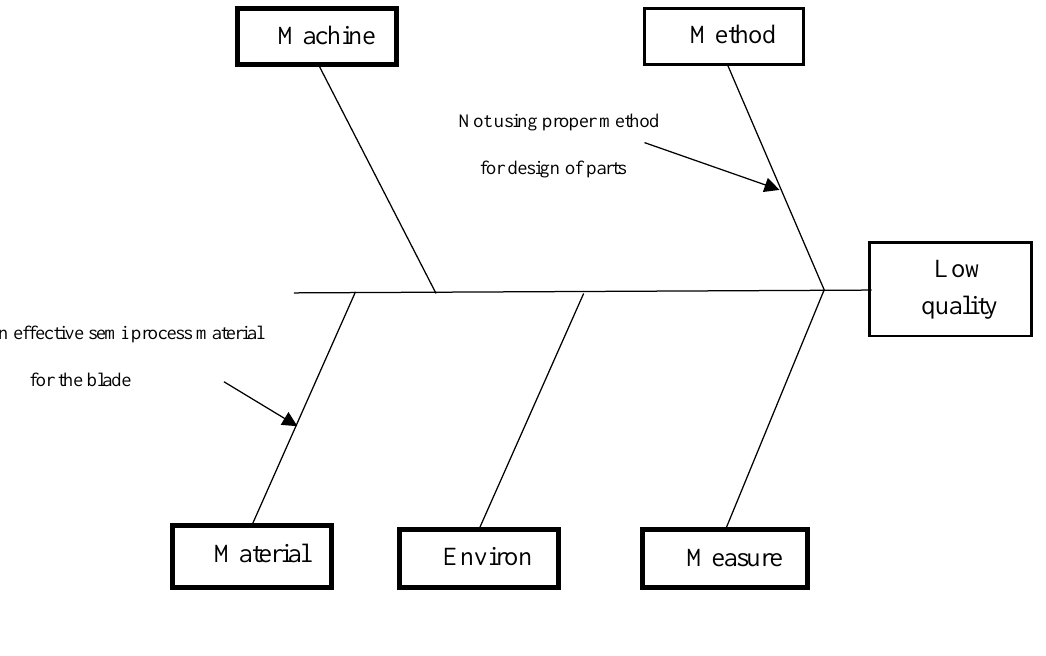
Figure 3. Cause and effect